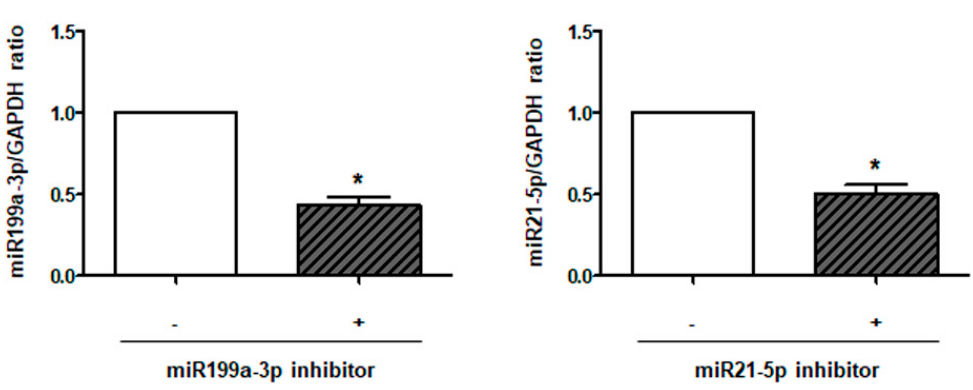
Figure A6. Validation of miRNA inhibitors for miR − 199a − 3p and miR − 21 − 5p. H9c2 cells were transfected with miRNA inhibitors (100 nM) targeting miR − 199a − 3p and miR − 21 − 5p. The levels of miR199a − 3p and miR21 − 5p were measured by qPCR ( n = 5). * Significant difference compared to the control ( p < 0.05).